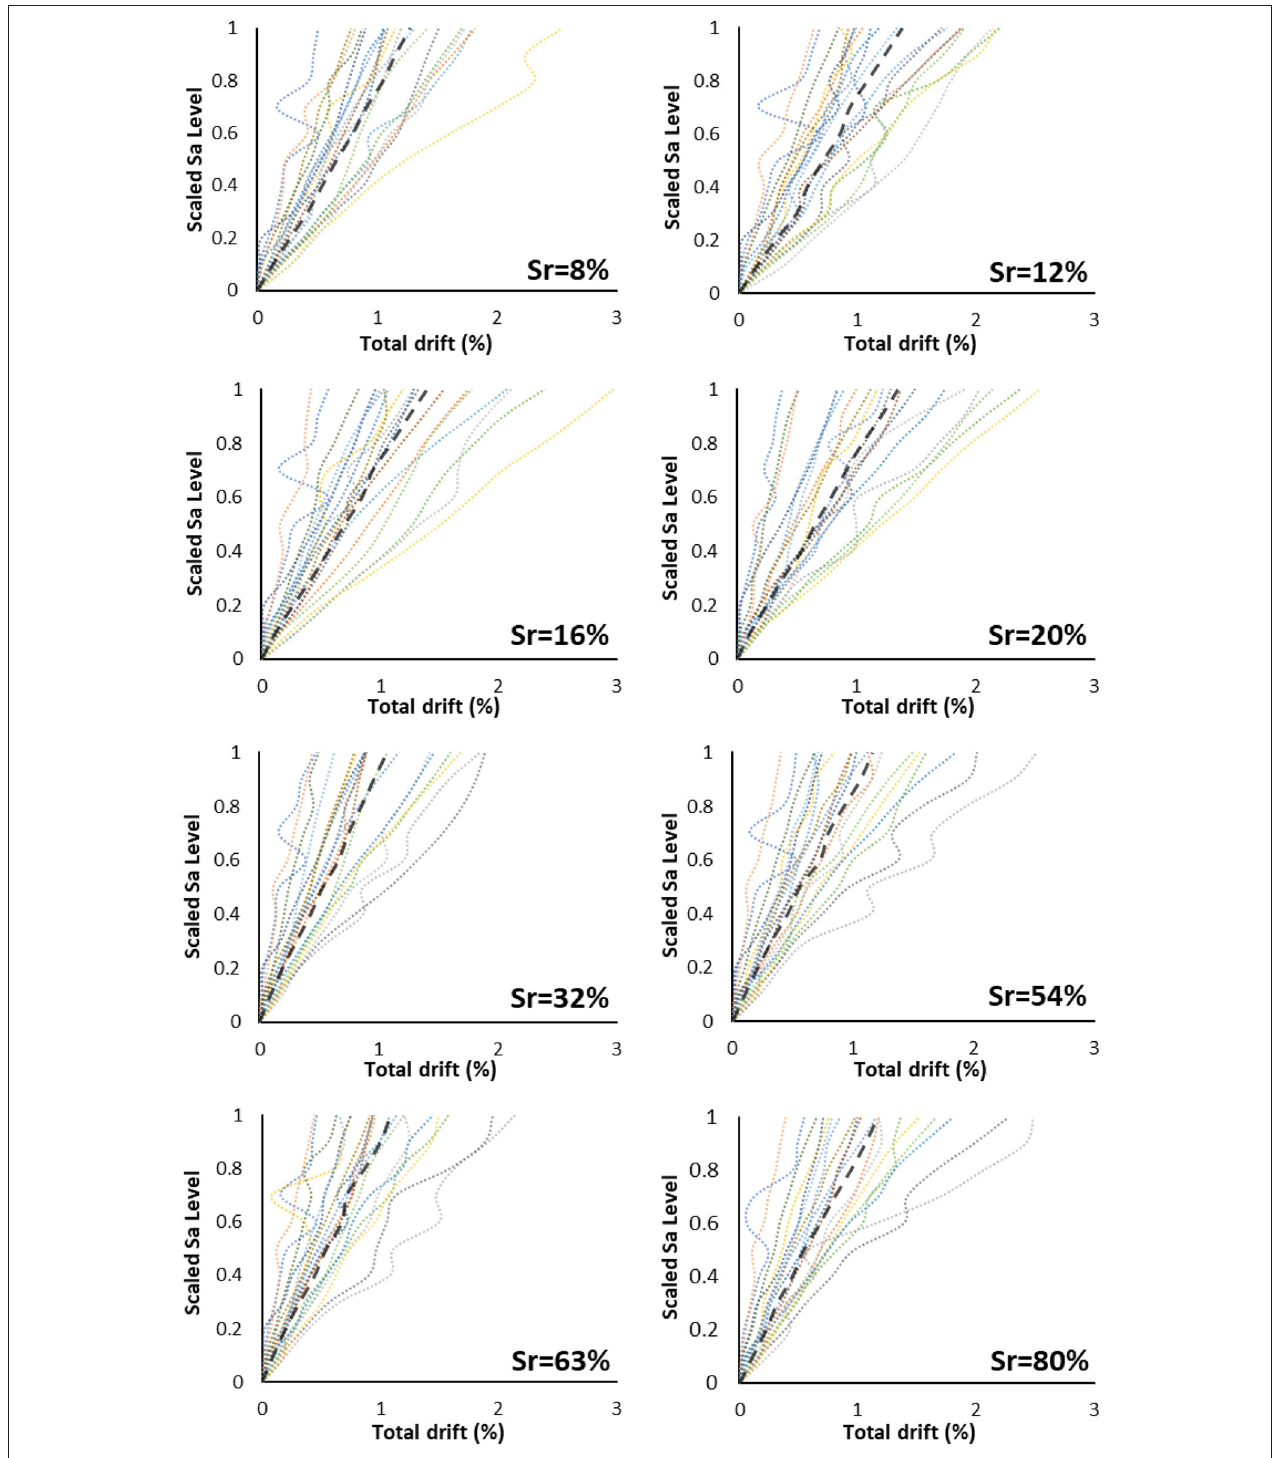
FIGURE 9 | Total drift MSDA curves for the retrofitted building, in which dashed curves show median